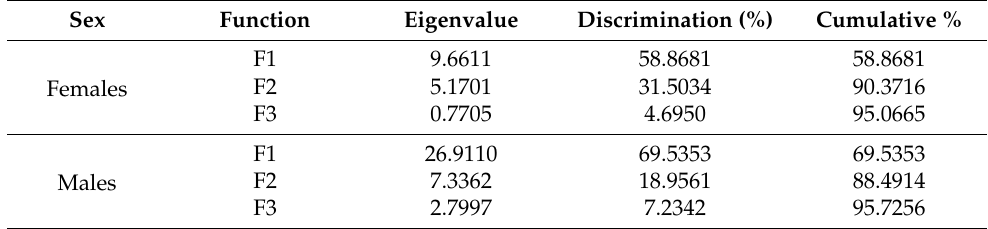
Table 5. Canonical variable functions and percentage of self-explained and cumulative